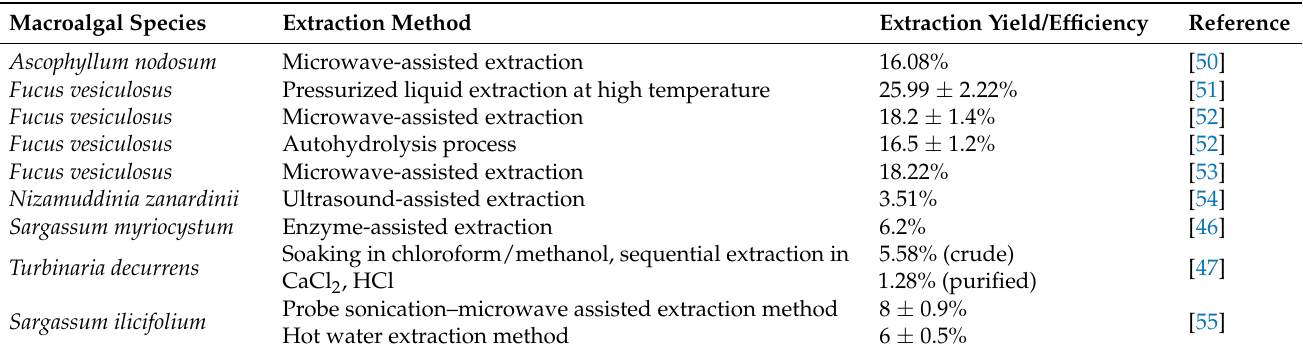
Table 2. Methods of extraction of fucoidan from macroalgal